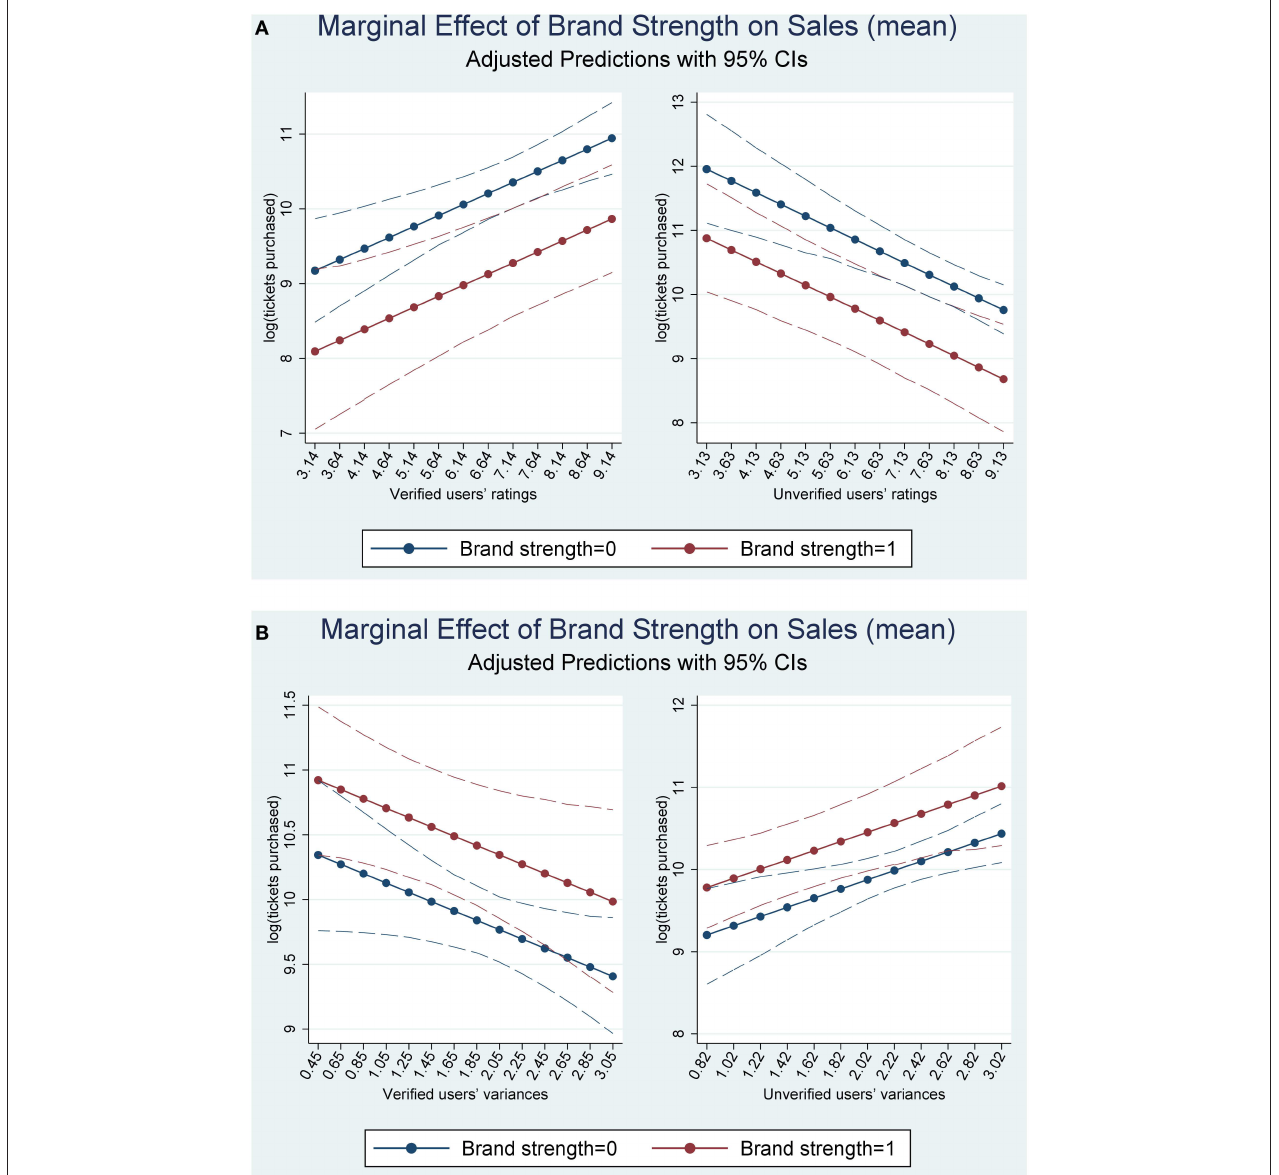
FIGURE 2 | Interactions between online reviews and brand strength. (A) Valence and brand strength. (B) Variance and brand strength. of ticket purchased for the films with strong star power becomes positive; nevertheless, the association of the reviews with the number of ticket purchased for films with weak star power remains